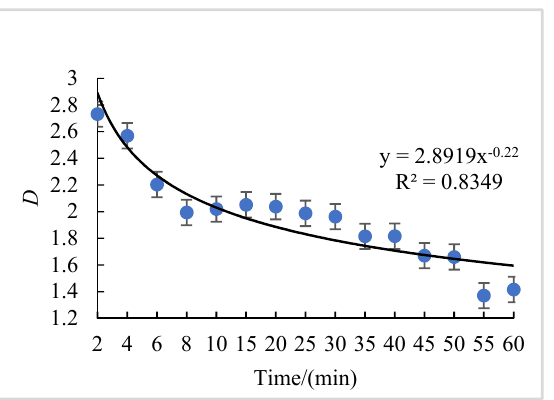
Figure 5. The change of fractal dimension D with time duration. Each error bar in the text is the standard deviation.